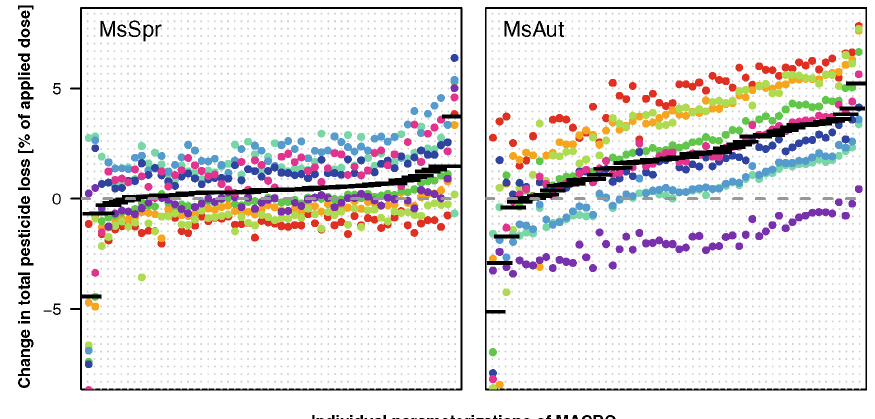
Fig. 7. Changes in pesticide leaching loss for the moderately sorbed pesticide applied in spring (MsSpr) and autumn (MsAut). The different coloured dots mark the different climate scenarios (same colour code as Fig. 1), the black lines denote the ensemble mean of the different climate scenarios for each parameterization ( x axes) and the grey dashed line marks the zero line, which denotes no change between present and future